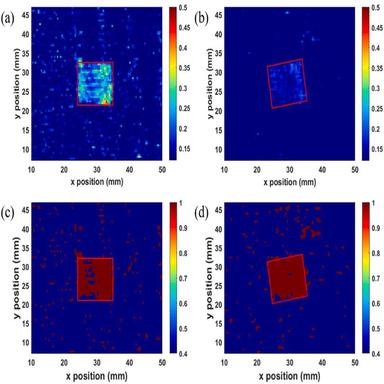
Quantification results obtained by the graph quantification strategy for both delamination defects D1 and D2. (a) Stratified C-scan image for D1 defects within the stratified range (8.98 ps, 10.97 ps). (b) Stratified C-scan image for D2 defects within the stratified range (16.97 ps, 18.97 ps). (c) C-scan after applying − 6 dB method for Fig. 13(a) to size the D1 delamination. (d) C-scan after applying − 6 dB method for Fig. 13(b) to size the D2 delamination.